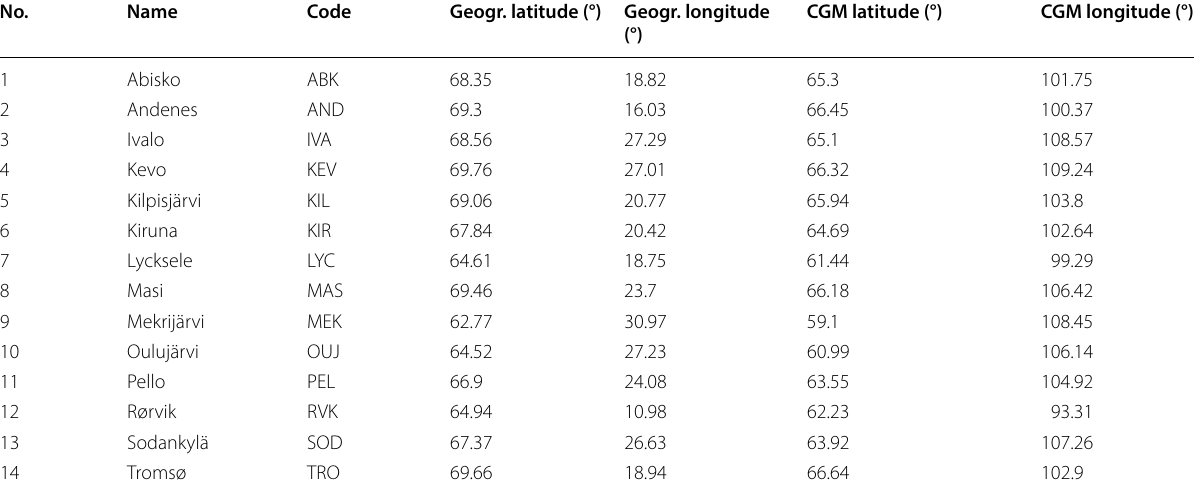
Table 1 List of selected ground magnetometer stations in the IMAGE magnetometer network and their geographic and corrected coordinates